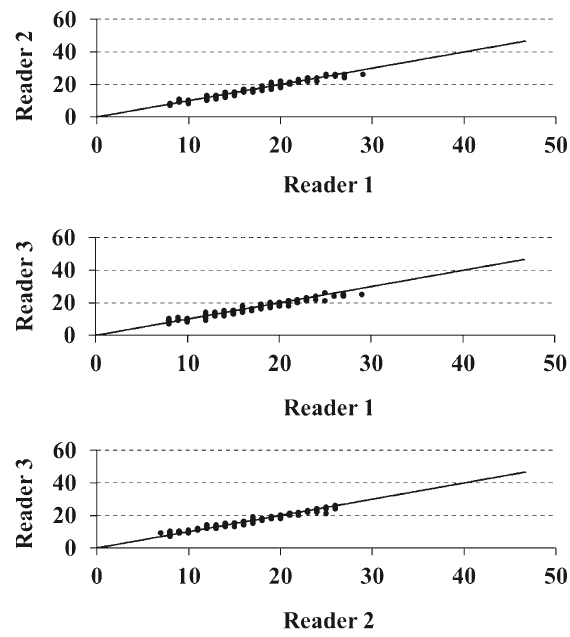
f iG . 5. – Box plot of the differences resulted from the comparisons of the age assigned by the three readers and Pontinus kuhlii total length ( o median; n 25%-75%; o